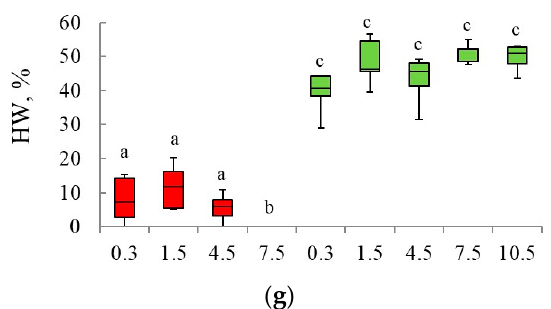
Figure 3. Characteristics of the xylem generally, sapwood and heartwood on sampled cores from pine trees. ( a ) Number of annual rings in the xylem (C.A.). ( b ) Radial width for xylem (R(W)). ( c ) The number of annual rings in sapwood (SW). ( d ) Sapwood area (S(SW)). ( e ) Number of annual rings in heartwood (HW). ( f ) Radial width in heartwood (R(HW)). ( g ) Heartwood proportion (HW (%)). Red boxes relate to the lichen pine forest, green boxes relate to the blueberry pine forest. The x-axis indicates the heights at which the cores were taken. Different letters indicate a significant difference at p < 0.05.